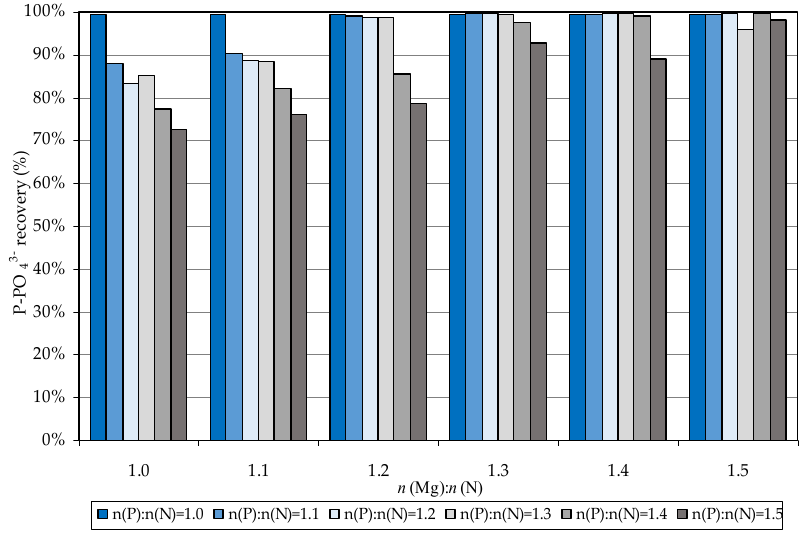
Figure 2. Phosphorus recovery during the tests conducted by using industrial grade reagents.